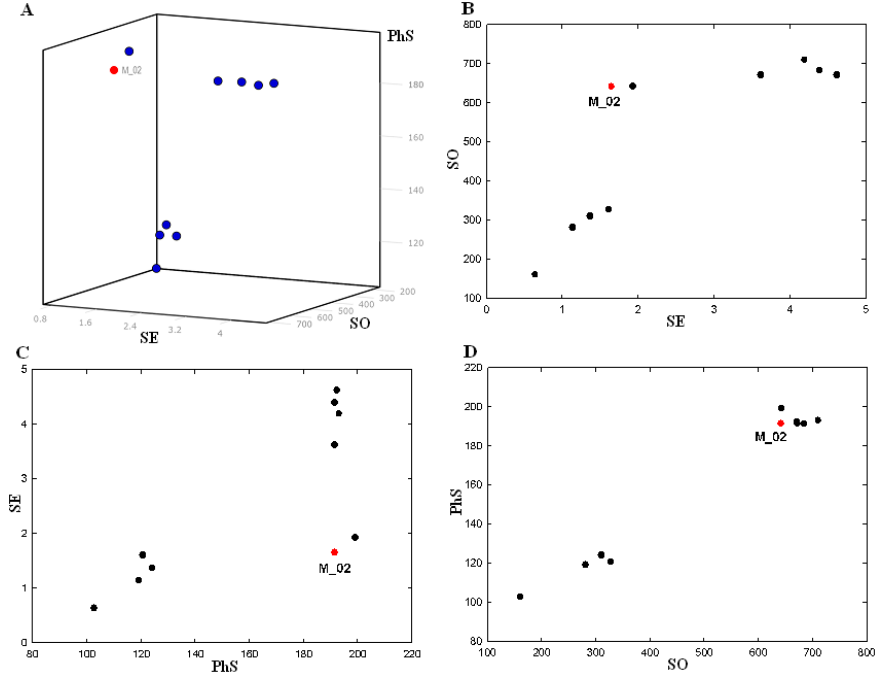
Figure 2. Plot of the strain energy (SE), steric overlap (SO) and pharmacophoric similarity (PhS) values for GALAHAD models with all five ligands with contribution to the consensus feature; ( A ) 3D plot; ( B ) plot of SO vs. SE; ( C ) plot of SE vs. PhS; ( D ) plot of PhS vs.